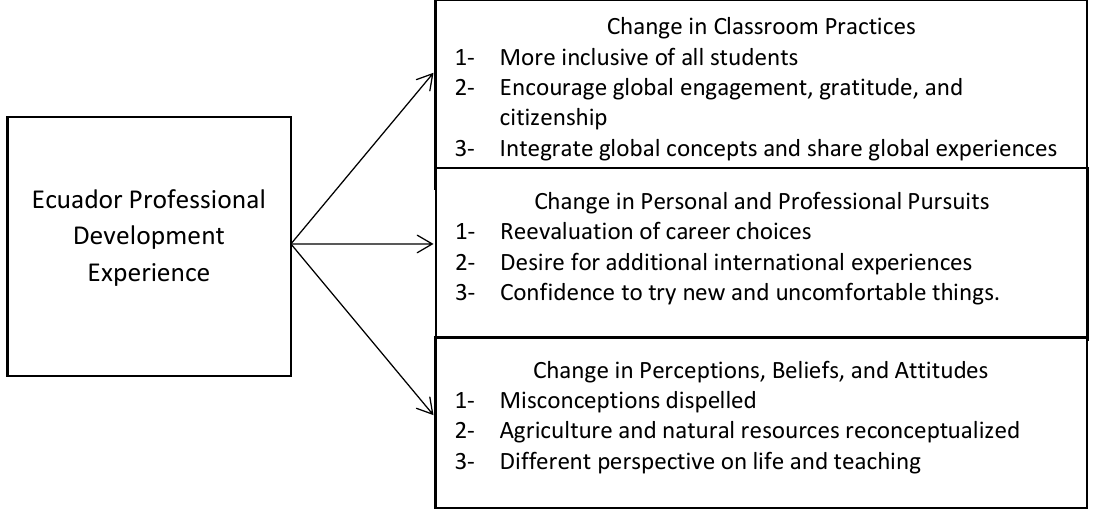
Figure 2 Visual Summary of